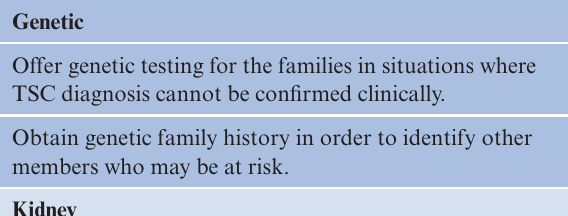
Table 2: Recommendations for physicians for potential TSC diagnosis.